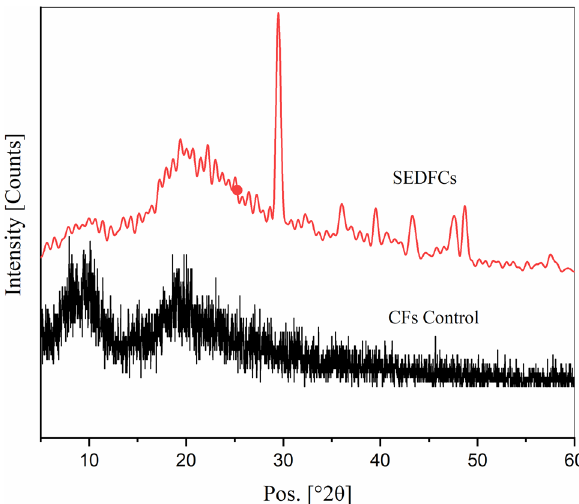
Figure 8. XRD patterns of CFs control (black) and SEDCFs (red).